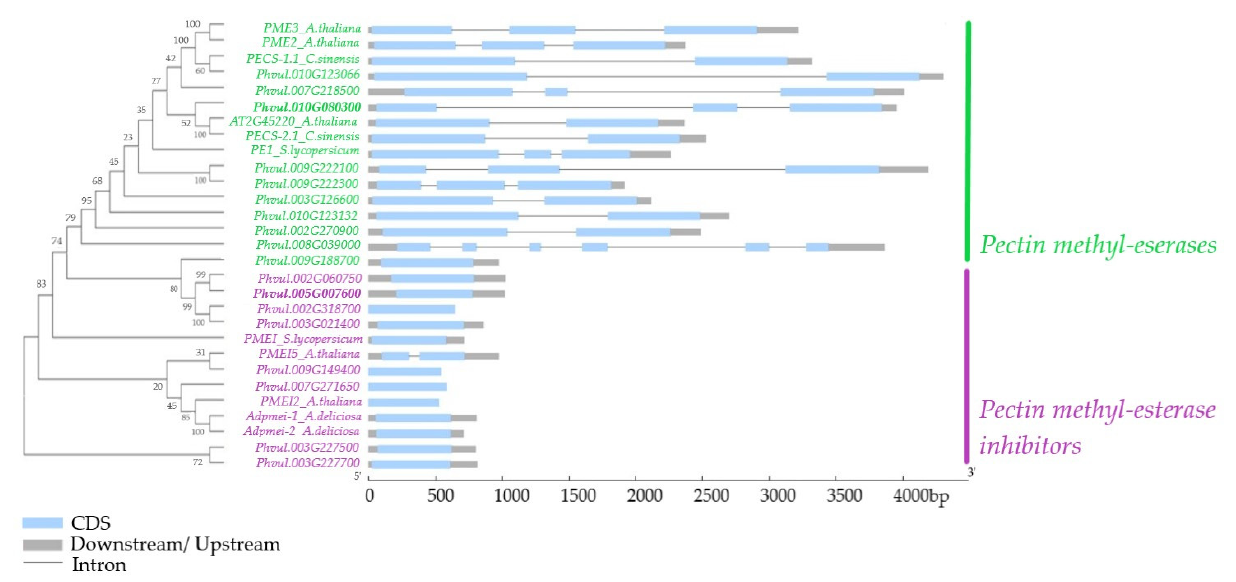
Figure 4. Phylogenetic tree showing the evolutionary relationship of highly expressed genes encoding pectin methyl-esterases (PMEs) and pectin methyl-esterase inhibitors (PMEIs) in P. vulgaris in comparison with those from other plant species ( A. thaliana , C. sinensis , S. lycopersicum, and A. deliciosa ).